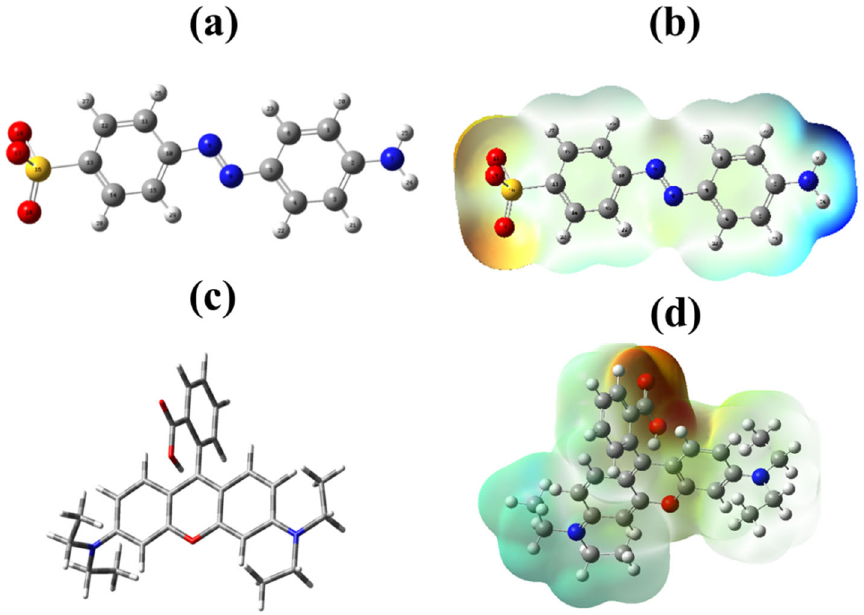
Figure 9. ( a ) Optimized structure of methyl orange, ( b ) MEP of methyl orange, ( c ) optimized structure of rhodamine ‐ B, and ( d ) MEP of rhodamine ‐ B.